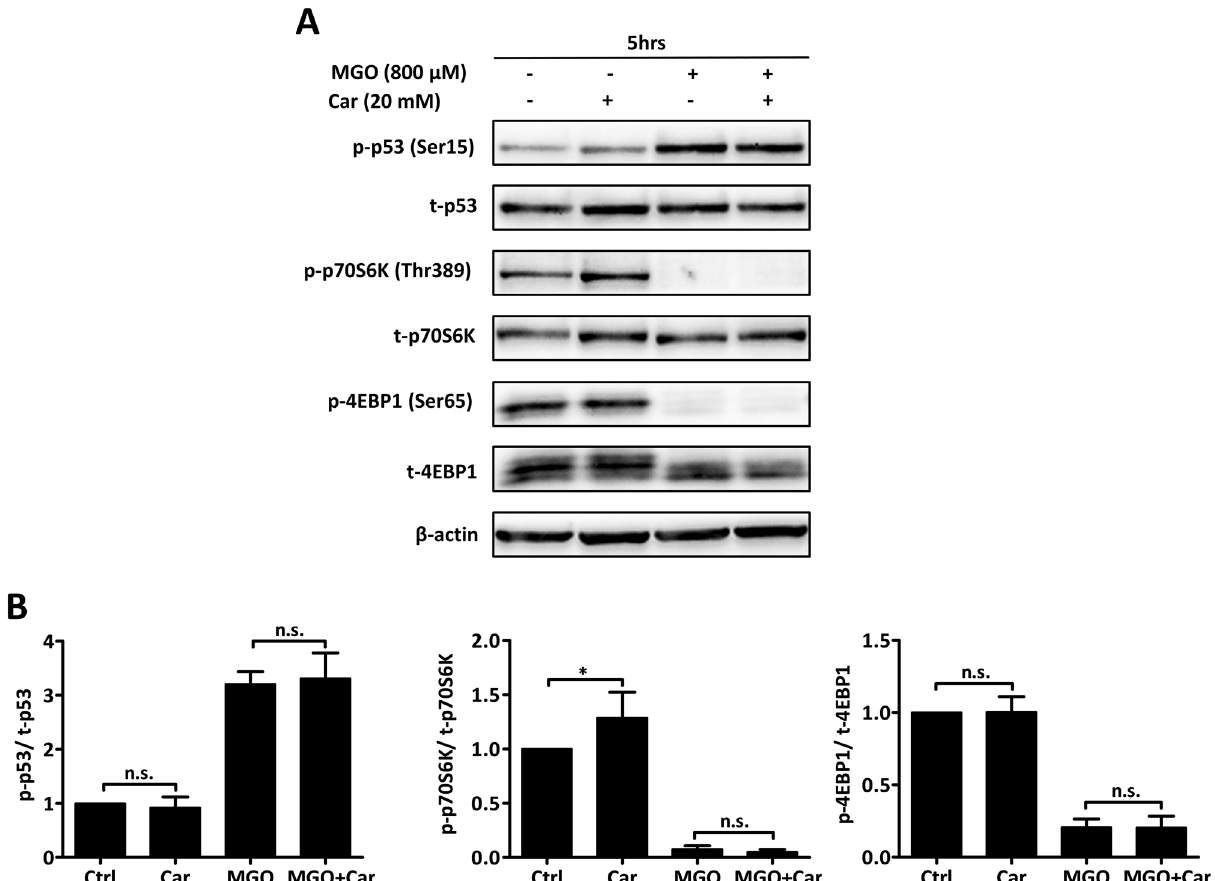
Figure 5. Carnosine does not ameliorate MGO-induced p53 activation or mTORC1 inhibition. ( A ) HUVECs were stimulated for 5 h with 800 µM of MGO. Stimulation occurred either in the presence or absence of 20 mM carnosine (Car). Hereafter, the cell lysates were processed for gel-electrophoresis and western blotting using anti-phosphorylated (p-) and anti-total (t-) p53, p70S6K and 4EBP1. The results of a representative experiment are shown. Displayed are the cropped blots and original blots are provided in Supplementary Fig. S5. ( B ) Quantification of 3 independent experiments was performed by densitometry. The results are expressed as mean p-/t-p53, p-/t-p70S6K and p-/t-4EBP1 ratio ± SD. * p < 0.05 vs. no MGO, n.s. represents